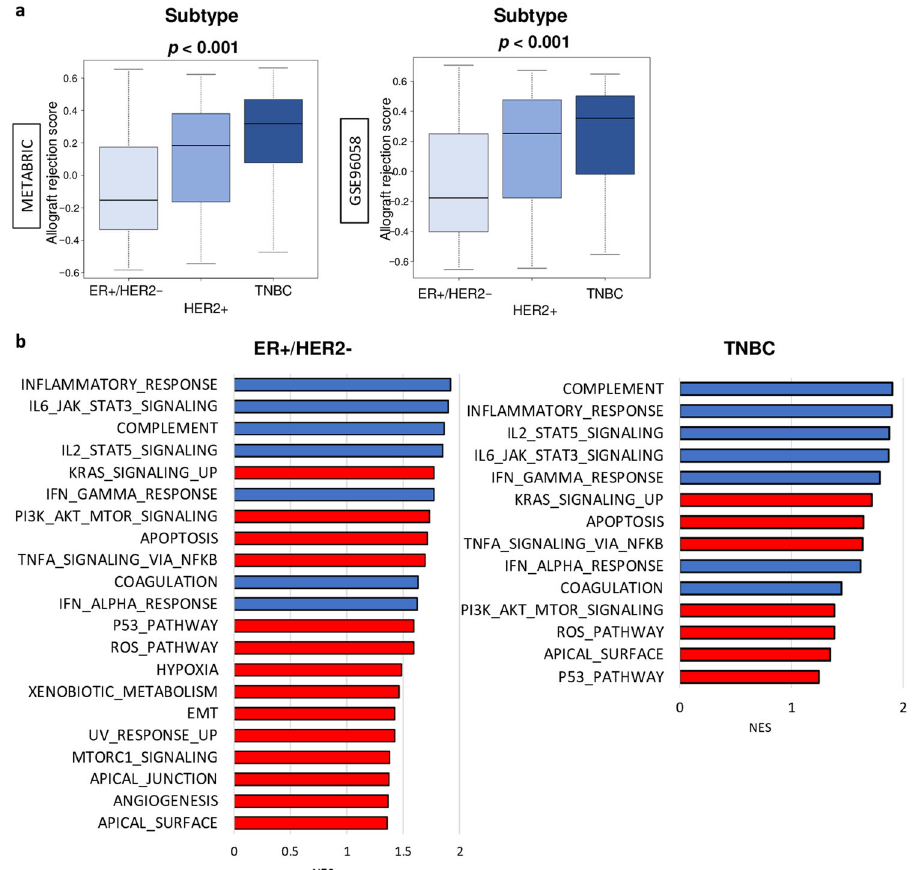
Fig. 5 TNBC with a high allograft rejection score was enriched with pro-cancer-related gene sets consistently in the METABRIC and GSE96058 cohorts. a Boxplots of the score by breast cancer subtypes in the METABRIC and GSE96058 cohorts. p -values were calculated by Kruskal – Wallis. Boxplots were of Tukey type, with boxes depicting median and inter-quartile range. b Bar plots of hallmark gene sets, which enriched in high score group within each subtype cohort in the METABRIC cohort. Blue bars are immune-related, and red bars are cancer aggressiveness-related gene sets. Spearman ’ s rank correlation was used for the analysis. EMTepithelial – mesenchymal transition, IFN interferon ROS reactive oxygen